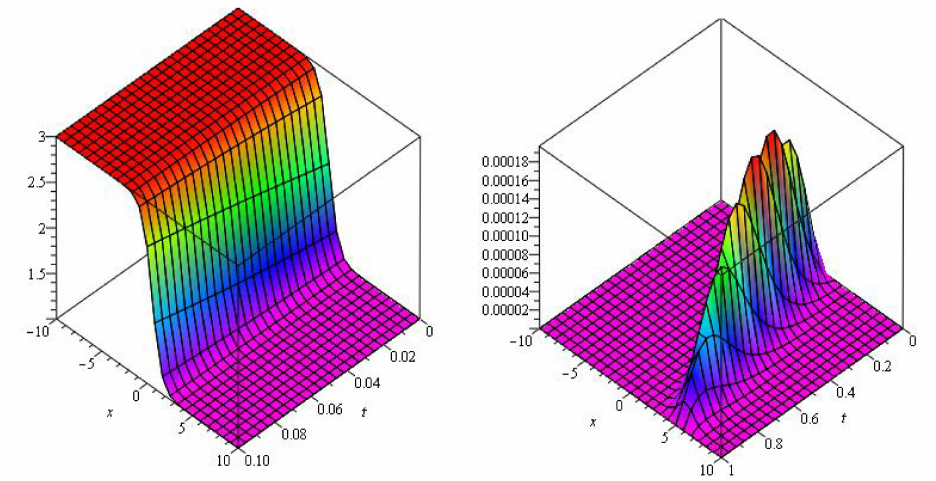
Figure 7. Graphs of ω ( ζ , τ ) and error plot at ρ = 1 of example